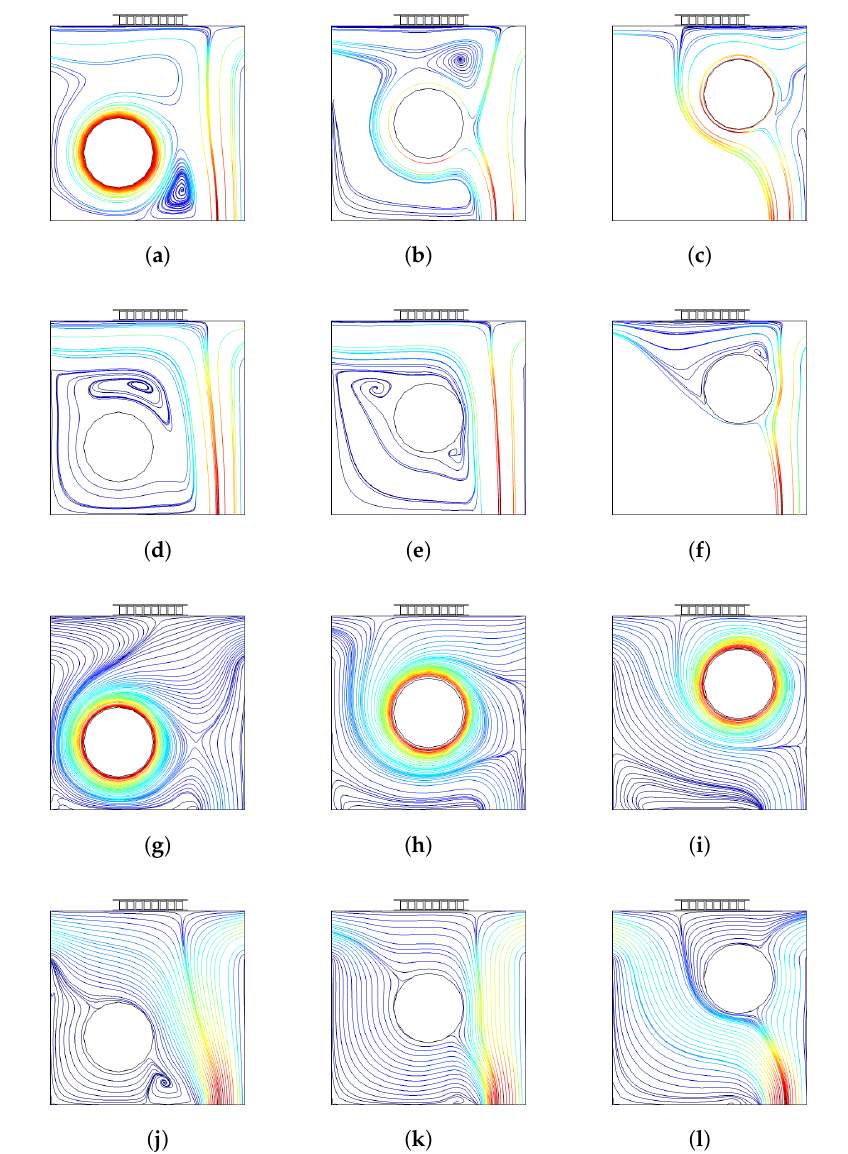
Figure 8. Impacts of location of the rotating cylinder on the FP distribution in the VC for NF1 ( a – f ) and for NF2 ( g – l ) (R = 0.18 Hm, Rew = − 3000 ( a – c , g – i ) and Rew = 0 ( d – f , j – l )). ( a ) (Yp, Zp) = (0.35, 0.35). ( b ) (Yp, Zp) = (0.5, 0.5). ( c ) (Yp, Zp) = (0.65, 0.65). ( d ) (Yp, Zp) = (0.35, 0.35). ( e ) (Yp, Zp) = (0.5, 0.5). ( f ) (Yp, Zp) = (0.65, 0.65). ( g ) (Yp, Zp) = (0.35, 0.35). ( h ) (Yp, Zp) = (0.5, 0.5). ( i ) (Yp, Zp) = (0.65, 0.65). ( j ) (Yp, Zp) = (0.35, 0.35). ( k ) (Yp, Zp) = (0.5, 0.5). ( l ) (Yp, Zp) = (0.65,